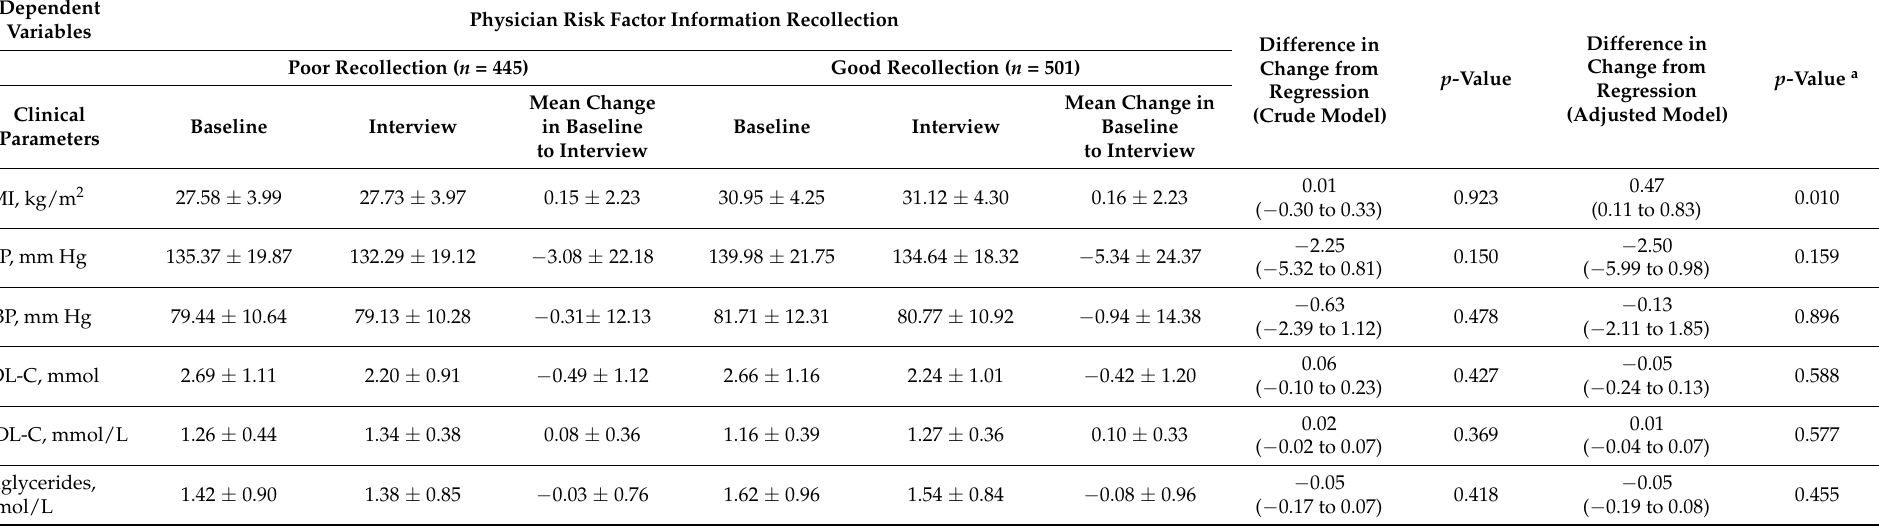
Table 3. Changes in Clinical Parameters Compared with the Status of Physician Risk Factor Information Recollection in Chronic Coronary Syndrome Patients.